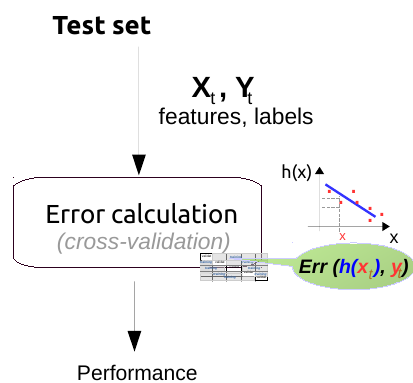
Figure 8. Testing the correctness of a model after the learning phase using a separate test dataset.